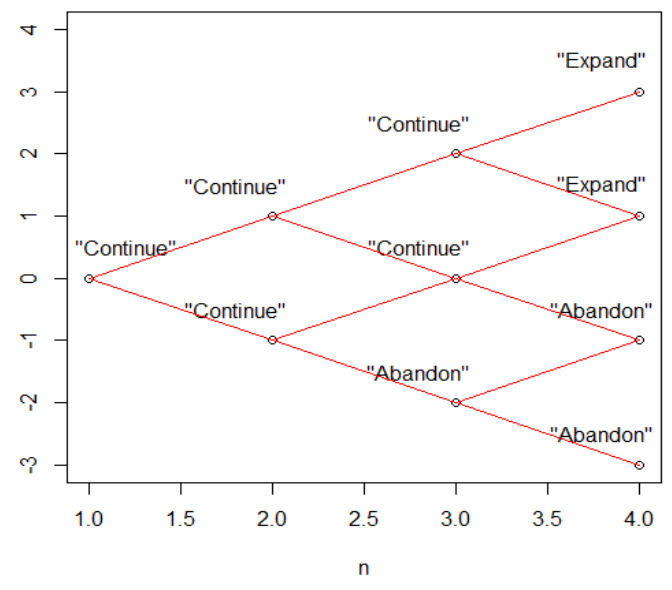
Figure 6. Option to choose. Tree with chosen options in each